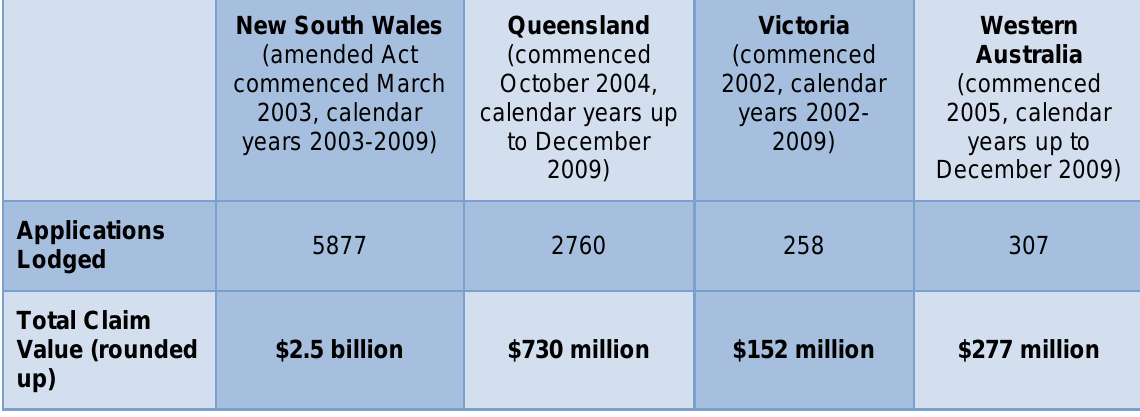
Table 2 Use of rapid adjudication – Interstate comparison